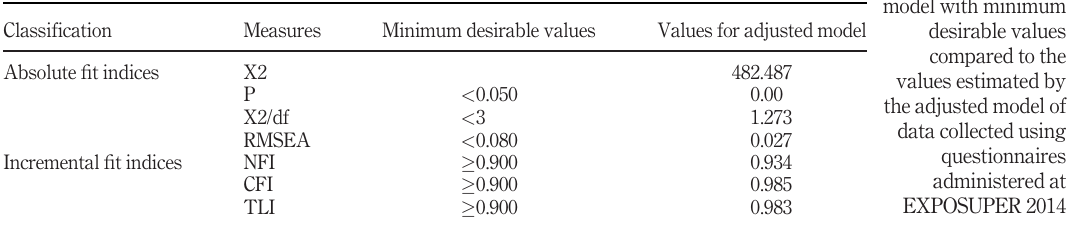
Table II. Fit indices for